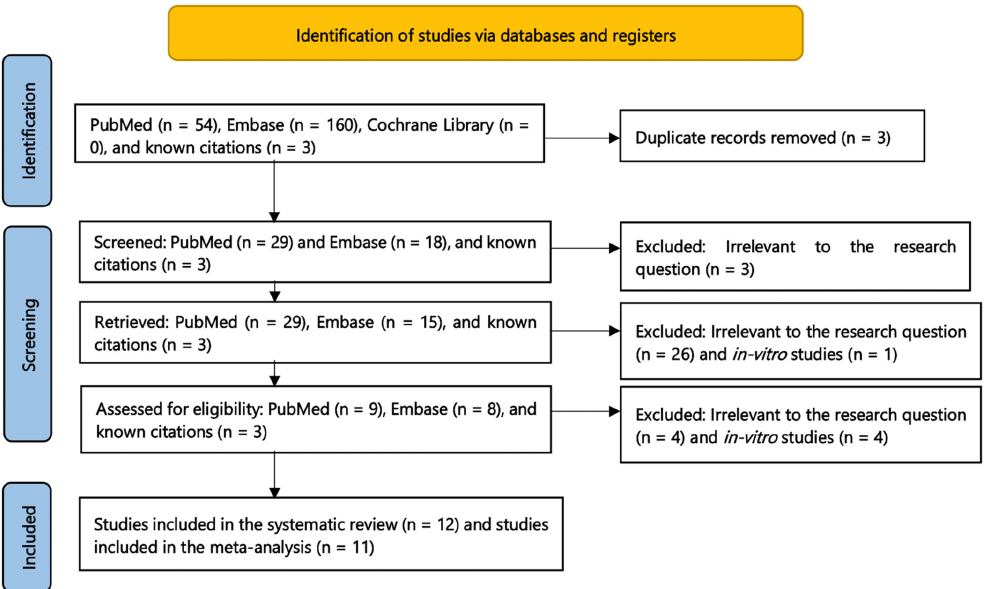
Figure 1. Flow diagram for Preferred Reporting Items for Systematic Reviews and Meta-Analyses (PRISMA).